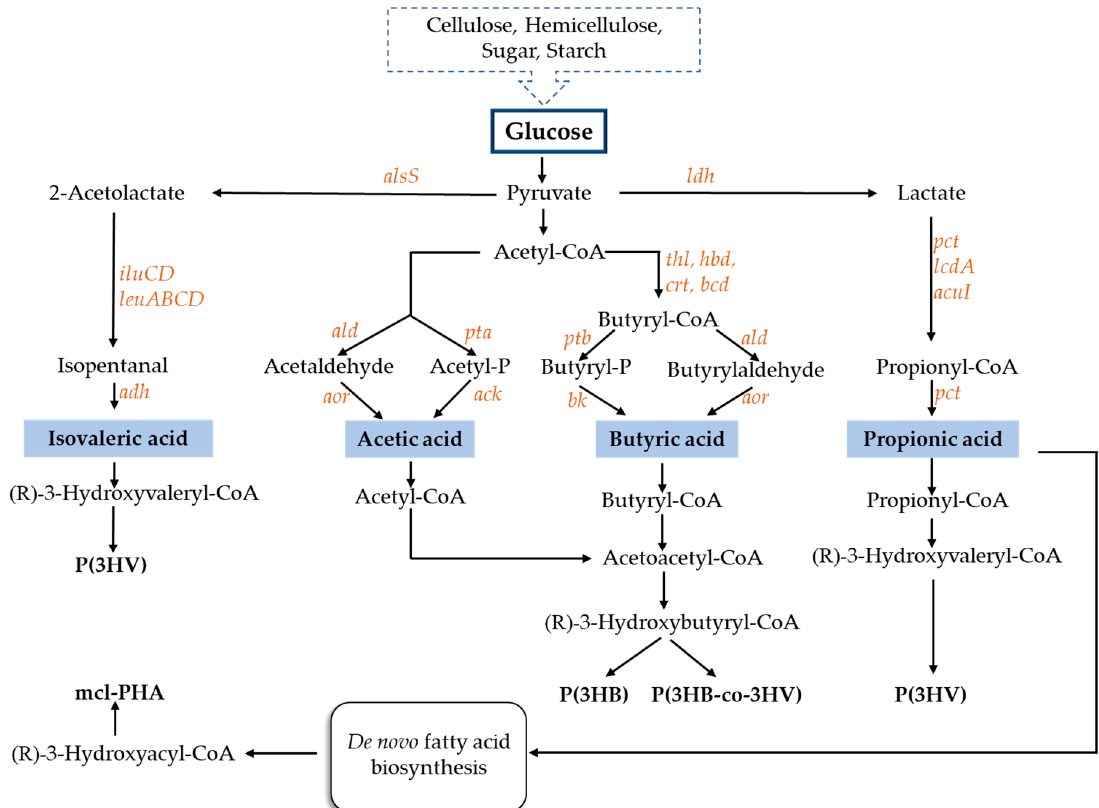
Figure 1. Scheme of metabolic pathways for volatile fatty acids production and polyhydroxyalkanoates synthesis. ack — acetate kinase, acul —acrylyl-CoA reductase, adh —alcohol dehydrogenase, ald— aldehyde dehydrogenase, alsS— acetolac-